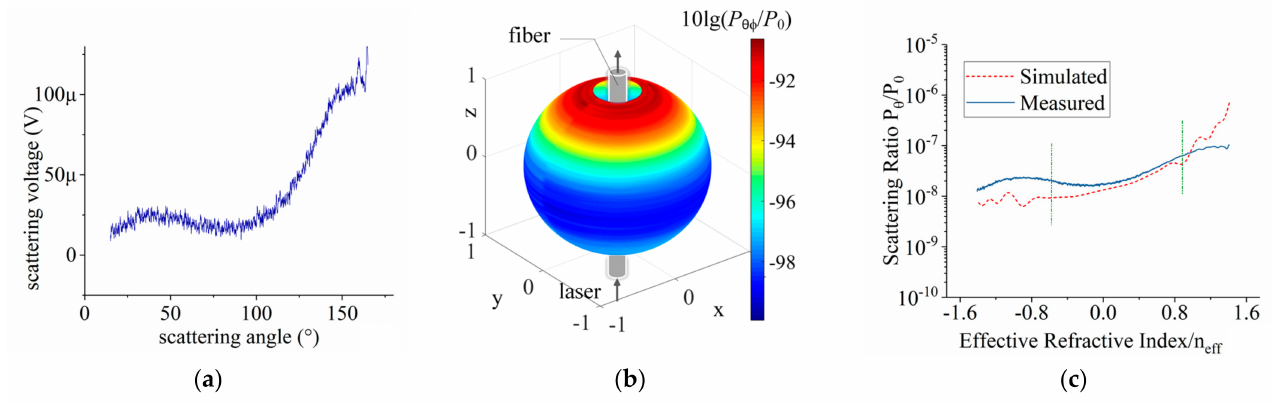
Figure 6. ( a ) The scattering voltage distribution of PM–PCF at one azimuth angle and ( b ) the spatial scattered power distribution sphere of PM–PCF and ( c ) the measured scattering distribution compared with simulation results.